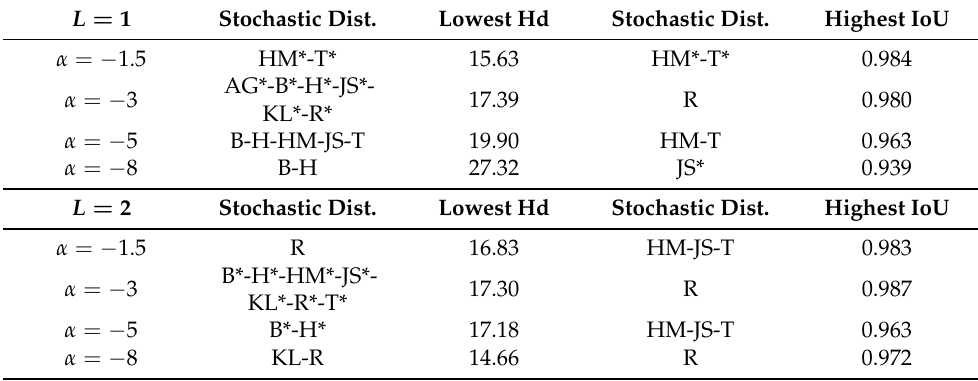
Table 5. Best quality measure values and the stochastic distance in which they are achieved for simulated